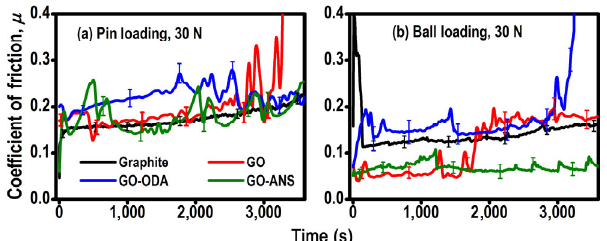
Fig. 6 Variation in friction coefficient with time data for the functionalized lubricant particles in the ambient from the (a) pin loading ( P m = 0.9 MPa) and (b) ball loading ( P m = 1.4 GPa) tribometric studies at normal load of 30 N with sliding speed of 0.4